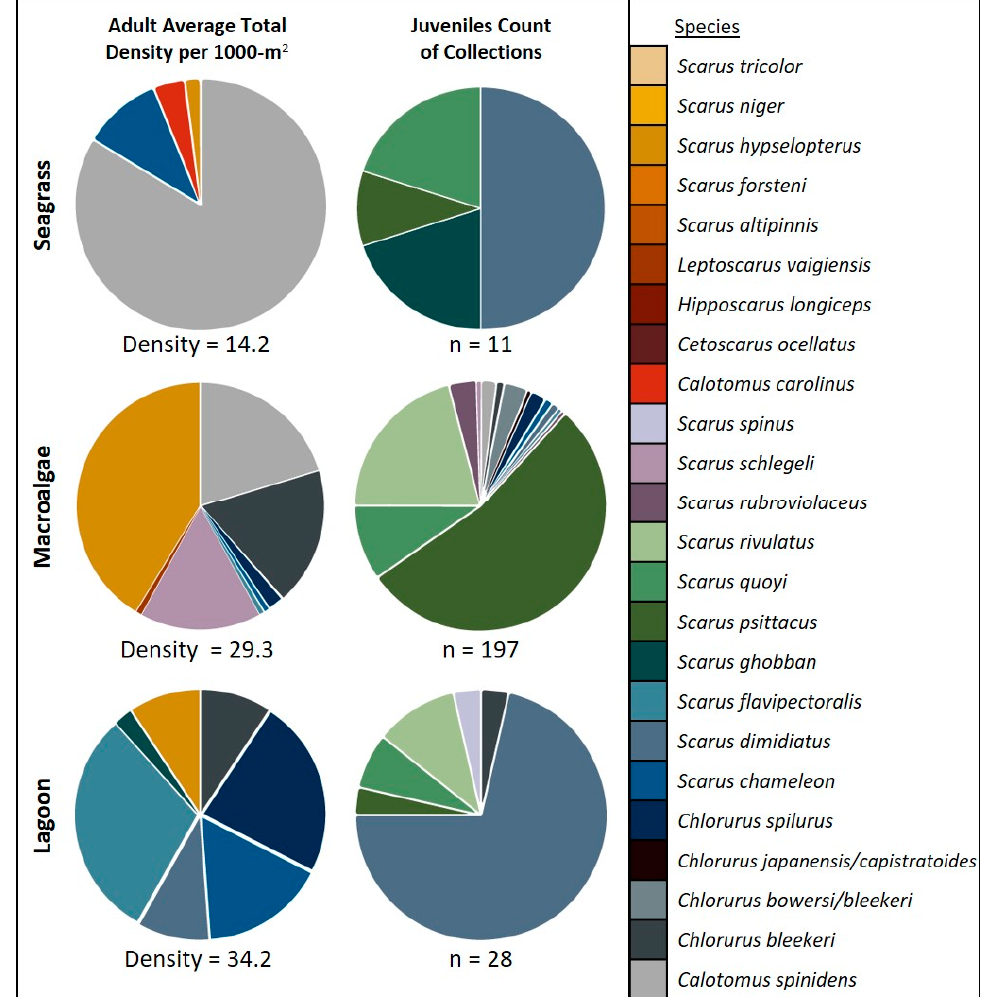
Figure 4. Comparing parrotfish species composition between seagrass habitat ( top ), macroalgal bed habitat ( middle ), and lagoon habitat ( bottom ) for adults identified on surveys ( left ) and juveniles identified through DNA analysis ( right ): adults are represented as the average total density per 1000-m 2 . Juveniles are reported as the total number of individuals collected in each habitat, reported as n.